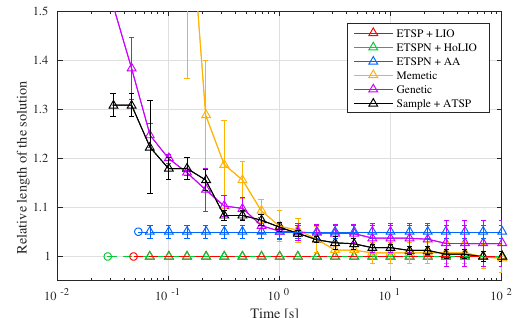
Figure 3. Average ratio of the tour length (from 50 trials) according to the ETSP+LIO solution for the DTSPN with n =20 convex regions. Plots start from the time when the first solution is available.